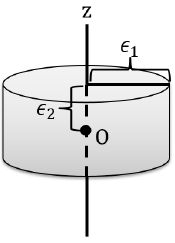
Figure 1. Unit ball of cylindrical norm (cid:107) · (cid:107) ( (cid:15)